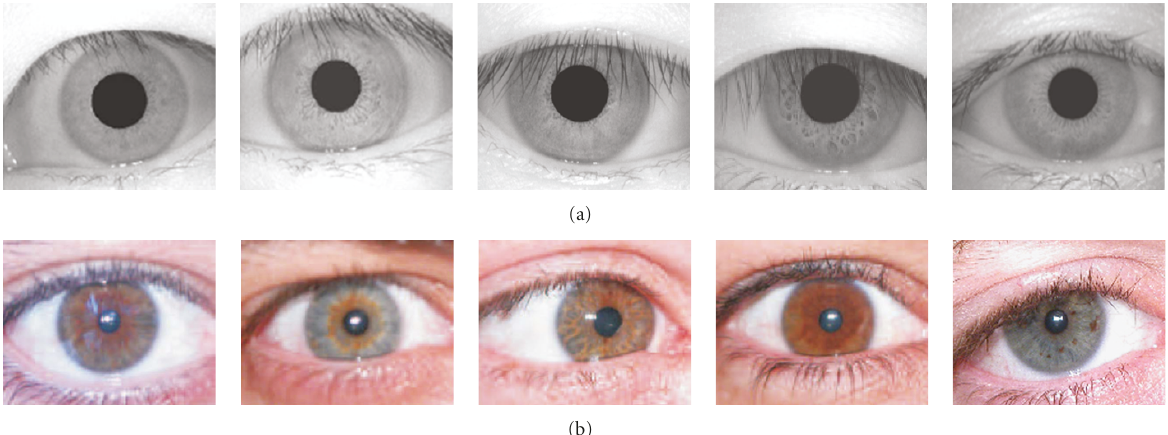
Figure 5: Iris samples from (a) CASIA Ver.1 and (b) UBIRIS.